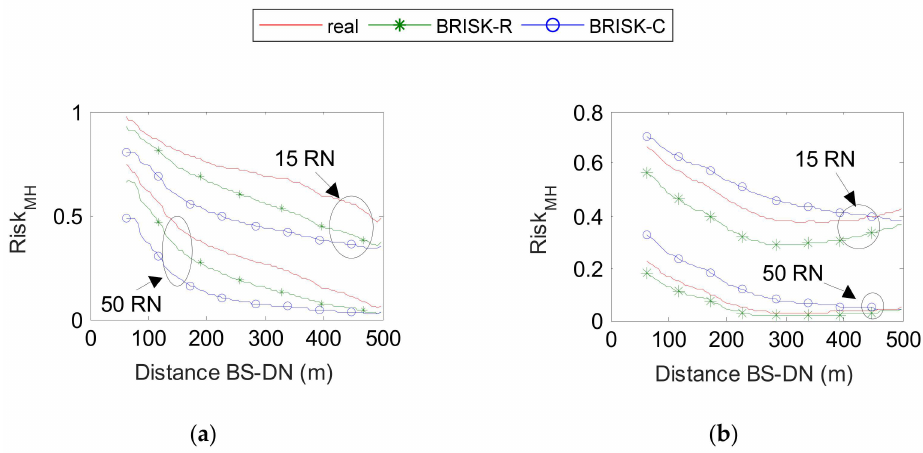
Figure 13. Real and estimated risk of selecting MH as a function of the distance between DN and BS—15 RN and 50 RN web tra ffi c. ( a ) Homogeneous scenario; ( b ) Circularly symmetric